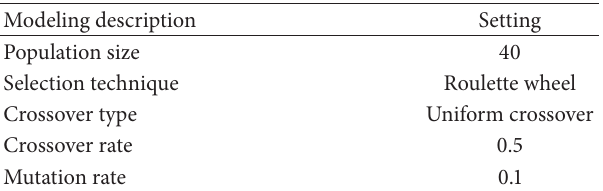
Table 1: Genetic algorithm parameters. Modeling